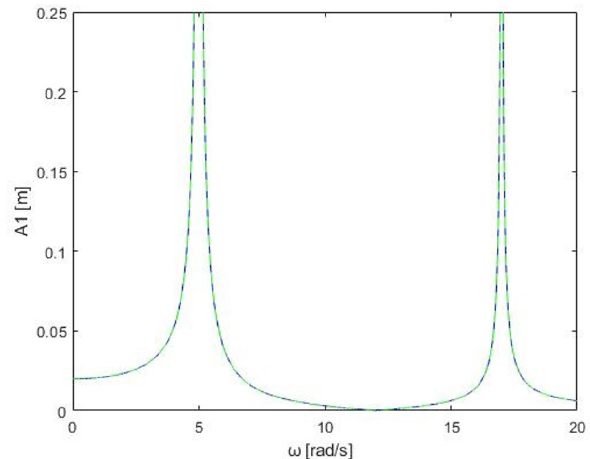
Figure 9. Displacement graph of mass 1 in relation to the vibration frequency spectrum (blue plot – structural number calculus; green plot – classical calculus).